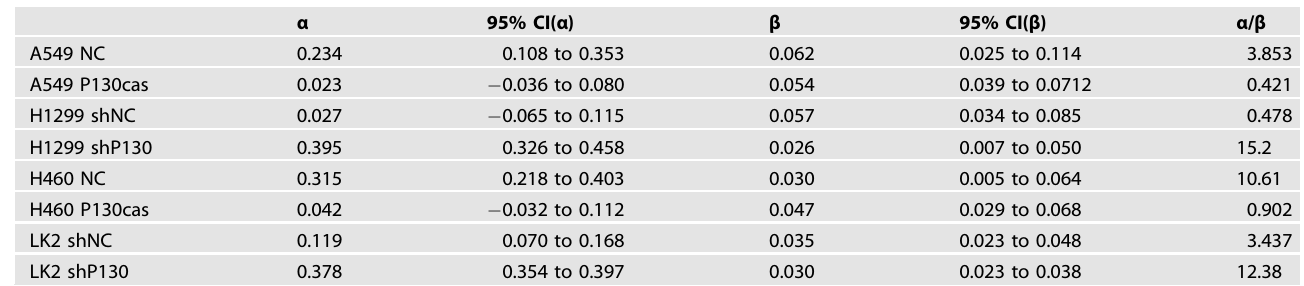
Table 2. Parameter of radiobiology fi tted linear quadratic